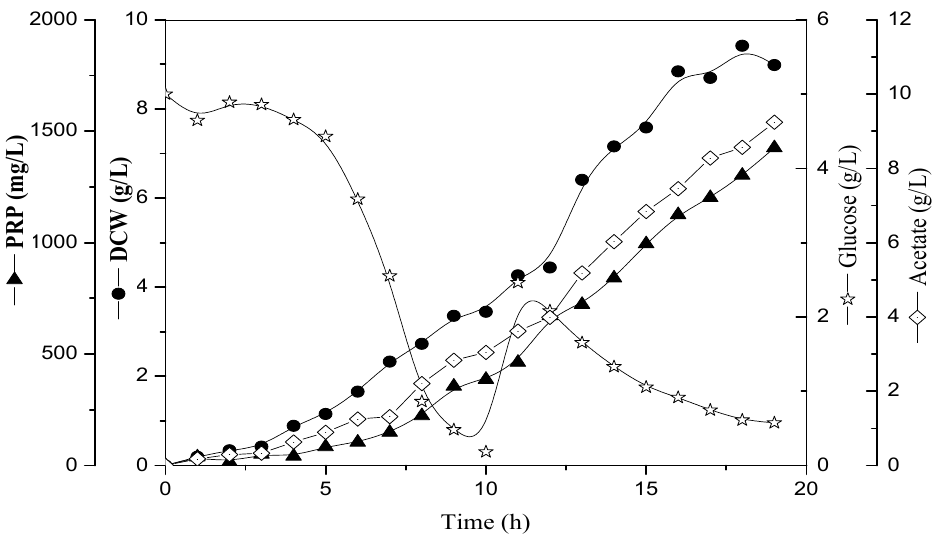
Figure 3. Time-course profiles of cell growth ( DCW ), glucose consumption, PRP production and acetate formation by H. influenzae at k L a values equal 52 h − 1 under two operation modes in 75 L pilot- scale, WV: 35 L −1 . Batch phase: 500 rpm and 0.15 vvm; Fed-batch phase: pO 2 at 30% of saturation. WV: Working Volume. Fed-batch phase was started at 10 h using external peristaltic pump.